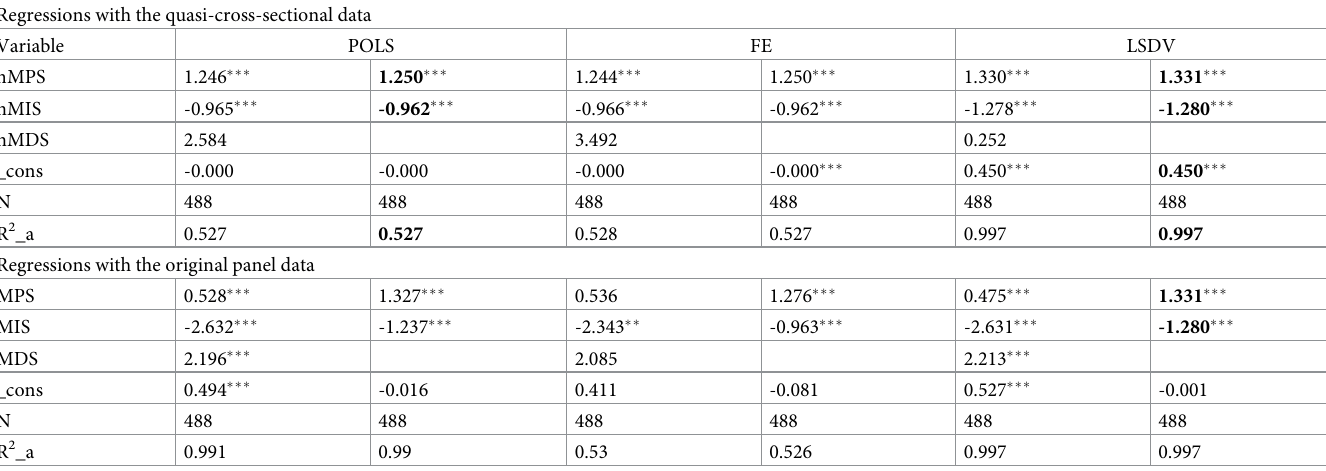
Table 5. Regression of the Gini coefficient on mean-income shares with trended time. Regressions with the quasi-cross-sectional data Variable